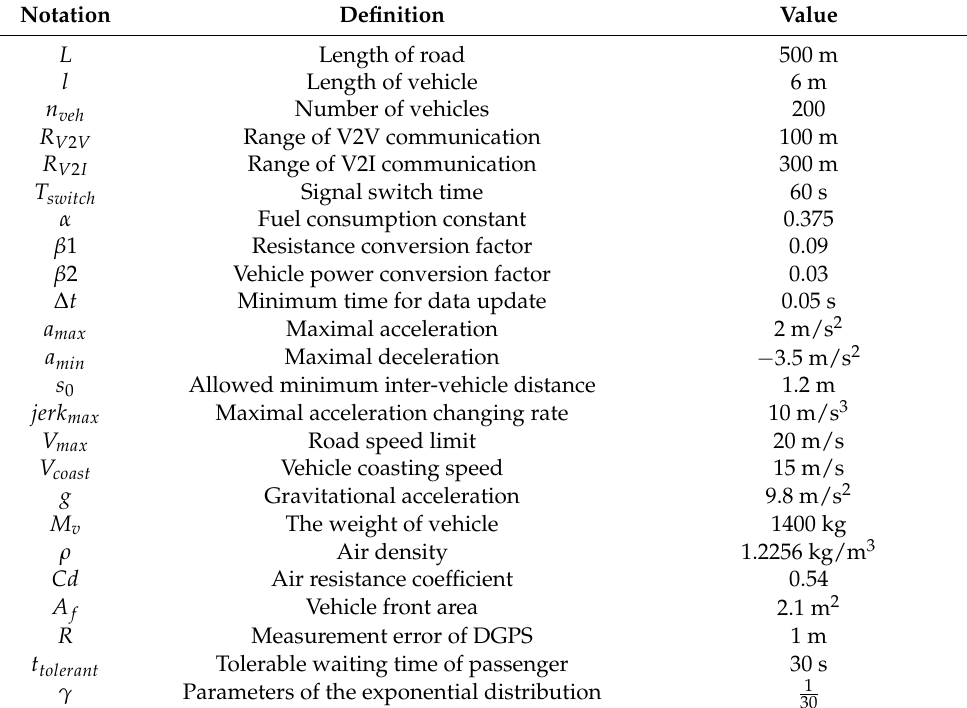
Table 1. Simulation